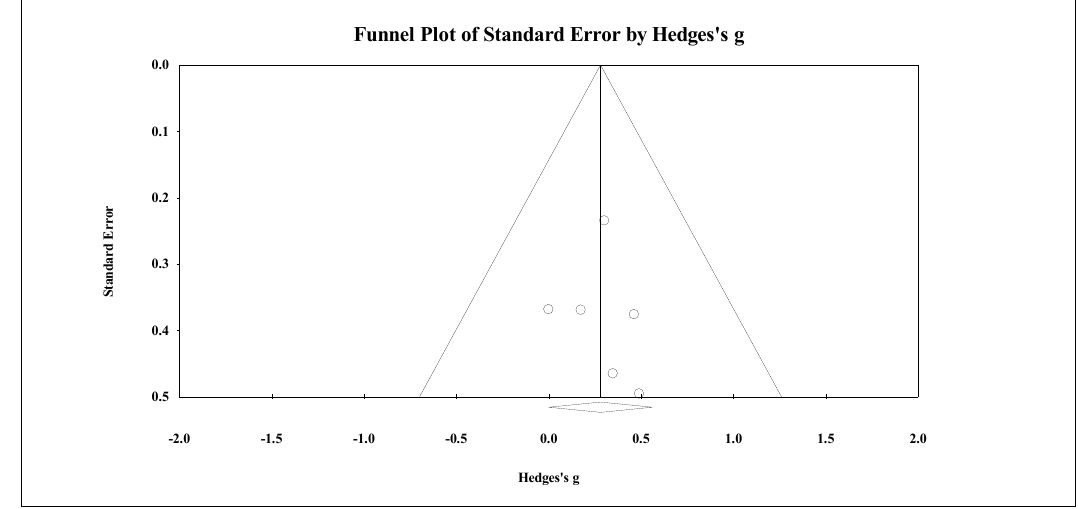
Figure 11. Funnel plot for changes in lower-body bone mineral density in untrained adults after a training program based on soccer small-sided games compared to an active control condition. White circles: observed studies. Seven studies provided data for lower body BMD, involving seven experimental groups (pooled n = 119). Results showed a small effect of SSGs on lower body BMD (ES = 0.42; 95% CI = 0.12 to 0.72; p = 0.006; I 2 = 74.6%; Egger’s test p = 0.035; Figure 12). After the Trim and Fill method was applied, the adjusted values was ES = 0.34 (95% CI = 0.04 to 0.64). For the assessment of publication bias, a funnel plot is presented in Figure 13. Figure 12. Forest plot of within-group changes in lower body bone mineral density (BMD) in untrained adults after a training program based on soccer small-sided games. Values shown are effect sizes (Hedges’s g) with 95% confidence intervals (CI). The size of the plotted squares reflects the statistical weight of each study. The black diamond reflects the overall result.